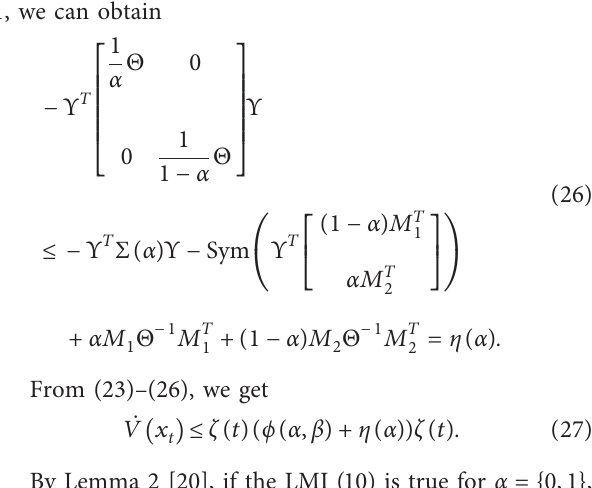
Table 1: Upper bound of h for Example 1 with different u .